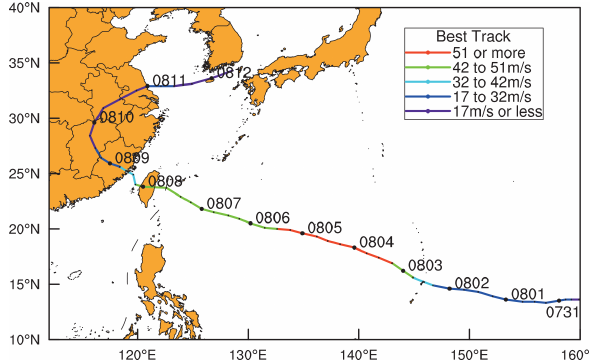
Figure 2. The best track of Soudelor from the China Meteorological Administration (CMA) from 00:00UTC on 30 July to 06:00UTC on 12 August 2015. Different colors represent intensity changes.